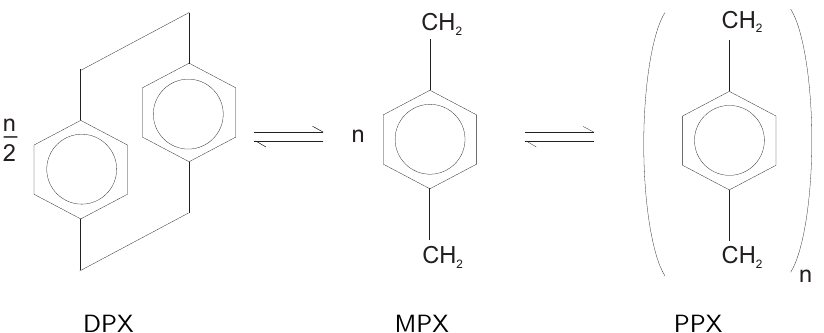
Figure 2. The dimeric species (di- p -xylylene, DPX, and LHS)—which contains two ethylene bridges in each p -position—acts as precursor and is cracked to form the monomer ( p -xylylene radical, MPX, and middle), which forms one-dimensional polymeric chains of poly - p -xylylene (PPX,